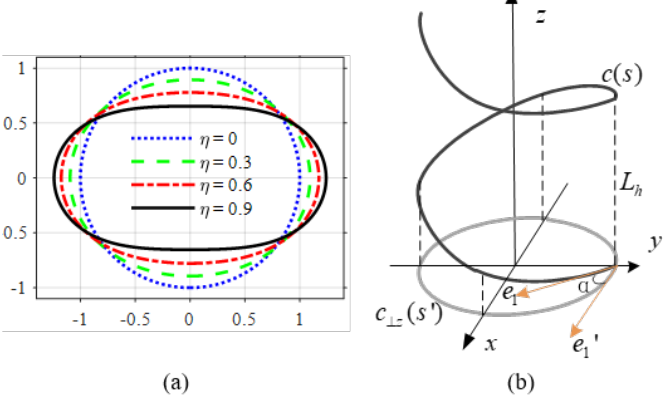
Figure 7. ( a ) Approximate Elliptic Curve. ( b ) Approximate Elliptic Helix Curve.